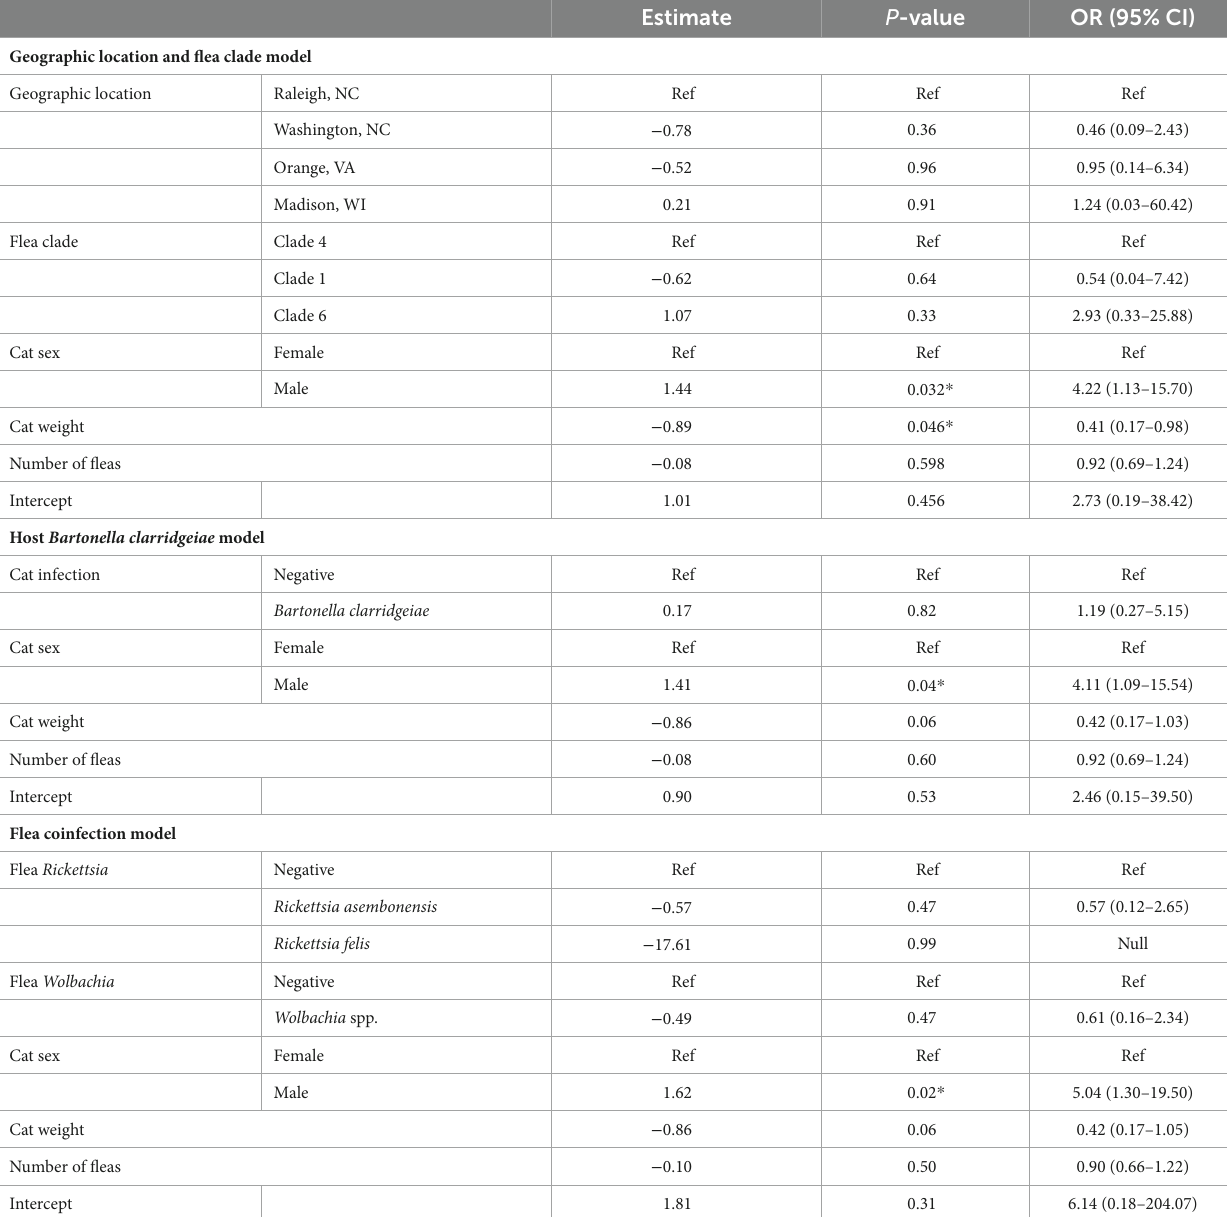
TABLE 5 Summary of the models created to assess the role of geographic location and flea clade, host B . clarridgeiae infection, and flea coinfection in Ctenocephalides felis B . clarridgeiae infection when cat sex, weight, and number of fleas are controlled